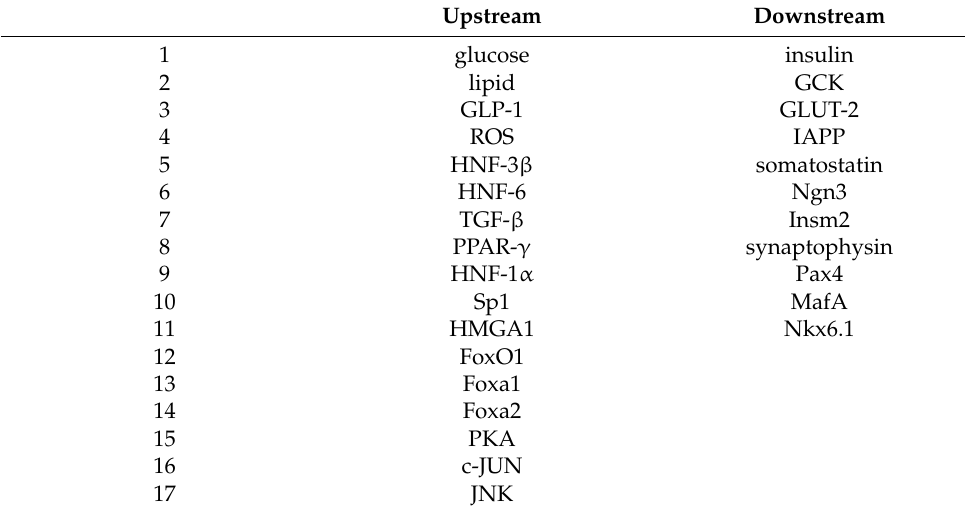
Table 1. The upstream and downstream targets of PDX-1